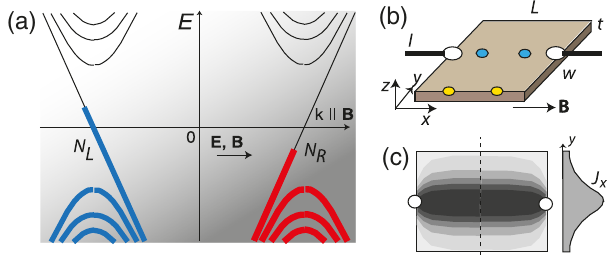
FIG. 1. (a) The Landau spectrum of Weyl fermions. In a field B k ˆ x , the lowest Landau levels are chiral with velocity v either k B or − B . Application of E k B transfers charge between them, which increases the left-moving population N L at the expense of the right-moving population N R (the bold blue and red curves indicate occupations of the LLs). Panel (b) shows a pair of voltage contacts (blue dots) placed on the line joining the current contacts (white circles). A second pair (yellow) is placed along an edge. Panel (c) is a schematic drawing of the intensity map of J x (with dark regions being the most intense) when current-jetting effects are pronounced. The profile of J x vs y (with x at the dashed line) is sketched on the